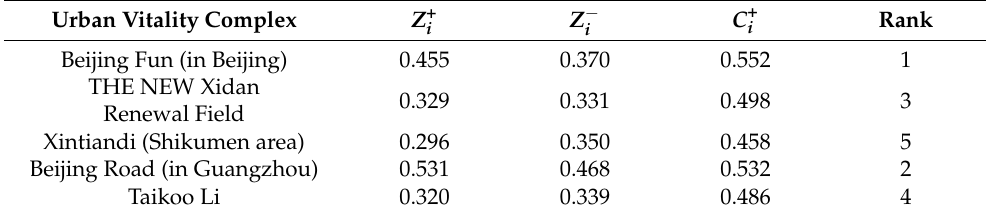
Table 12. Relative closeness and the vitality evaluation rank of five